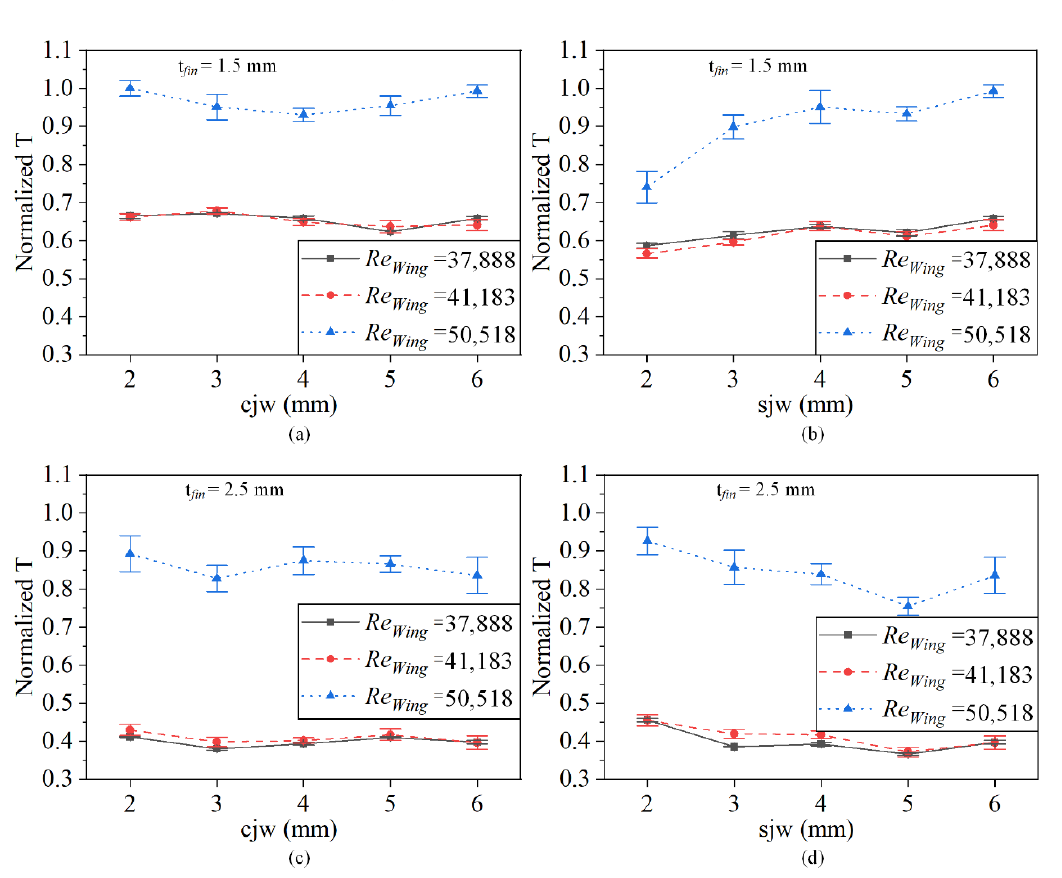
Figure 8. Variation of normalized T with various joint widths at Re Wing > 35,000. ( a ) t fin = 1.5 mm, variation of normalized T with cjw ; ( b ) t fin = 1.5 mm, variation of normalized T with sjw ; ( c ) t fin = 2.5 mm, variation of normalized T with cjw ; ( d ) t fin = 2.5 mm, variation of normalized T with sjw .